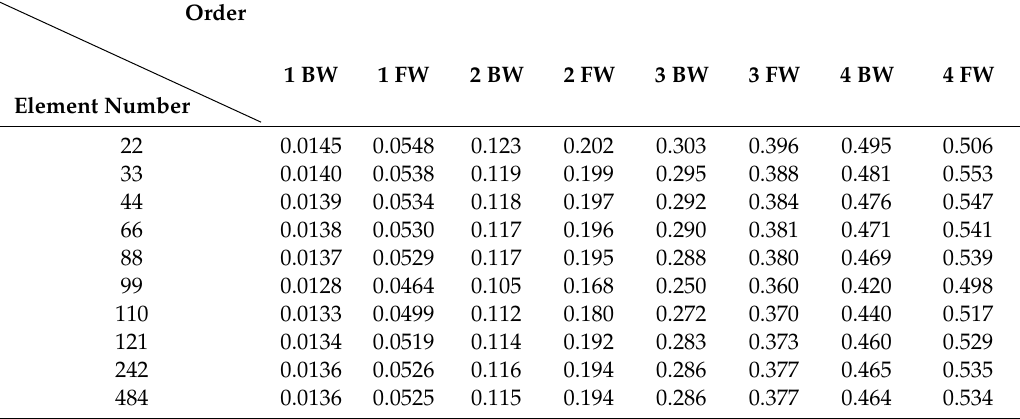
Table 12. Natural frequencies via spatial discretization ( h = 300 Nms).